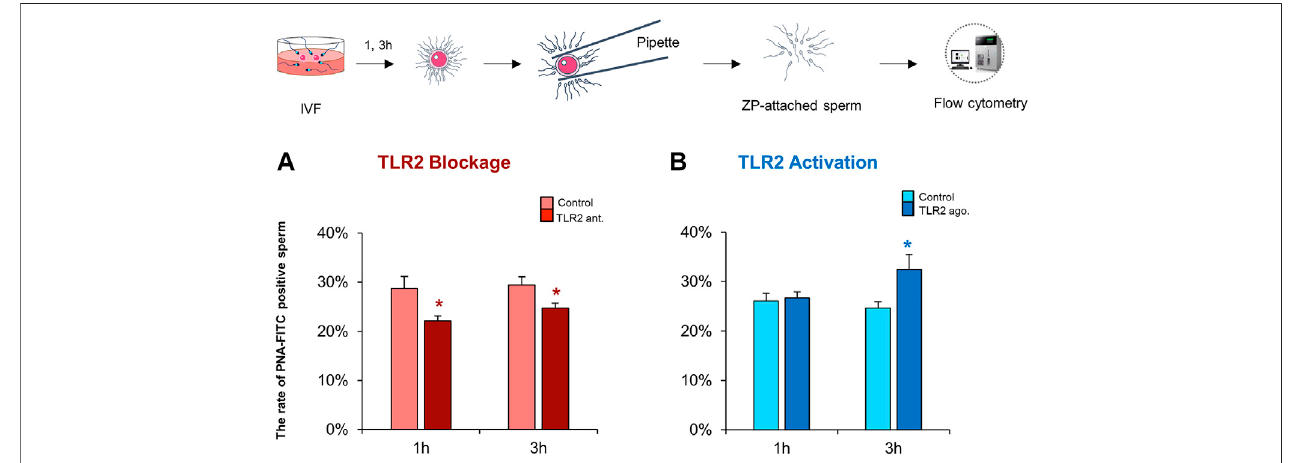
FIGURE 5 | TLR2 system impacts the ZP-induced acrosome reaction in sperm under IVF conditions. Sperm were pre-treated by TLR2 antagonist (100 µM) or TLR2 agonist (100 ng ml − 1 ) for 30 min, washed, and co-cultured with cumulus-free oocytes for 1 and 3 h. Then, ZP-attached sperm were collected and incubated with